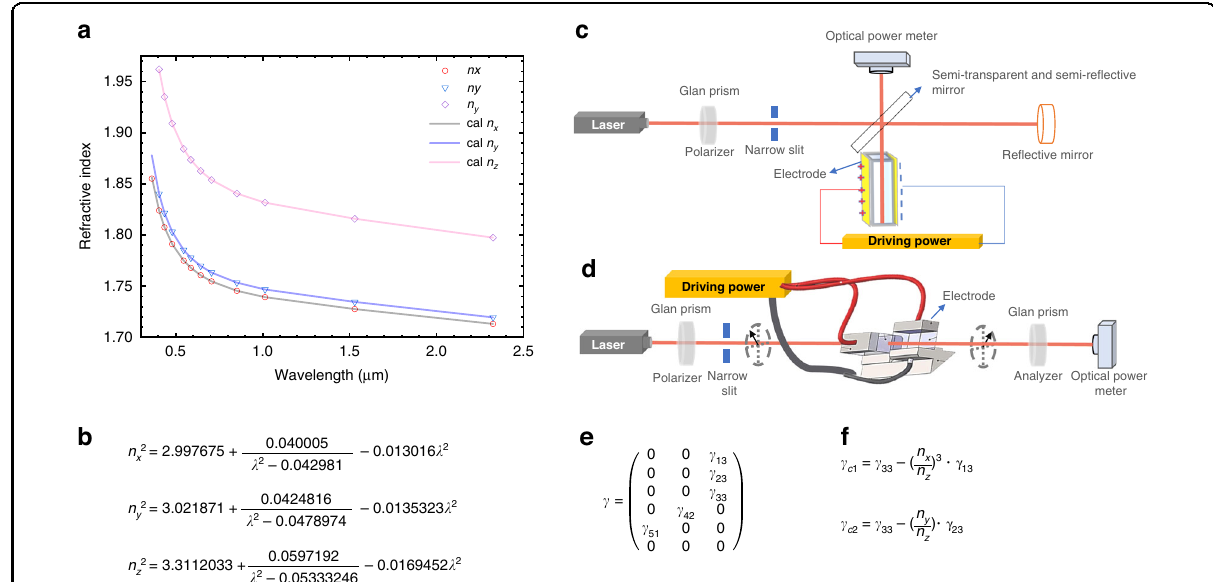
Fig. 8 Refractive index and electro-optic coef fi cient measurements in H-KTP. a Refractive index versus wavelength and b Sellmeier equation of KTP; Schematic of our custom-built single beam amplitude modulator for measuring c EO coef fi cients γ 13 , γ 23 , γ 33 and d effective EO coef fi cients γ c1 and γ c2 ; e EO coef fi cient matrix for KTP; f Calculation formula of the effective EO coef fi cients γ c1 and γ c2 through EO coef fi cients γ 13 , γ 23 , γ 33